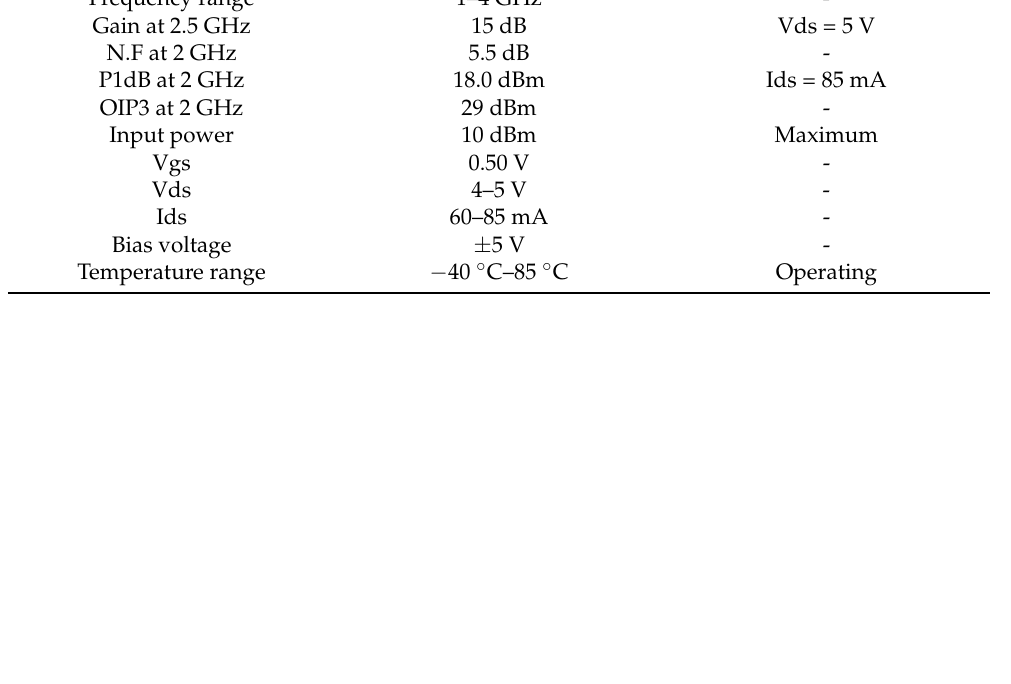
Figure 14. Active Circular Transmitting Patch antenna for Internet of Things (IoT) and 5G Applications.